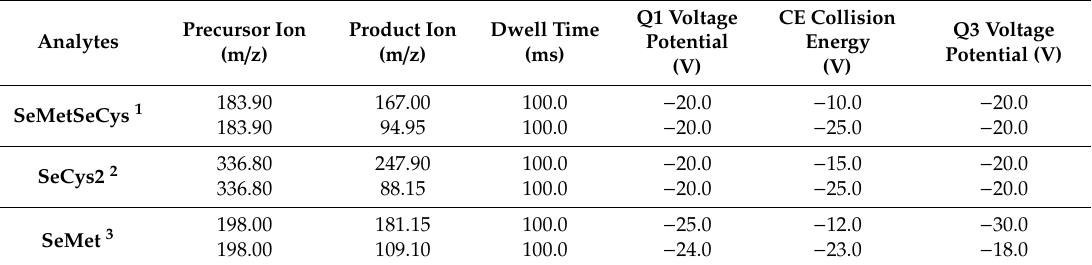
Table 2. The MS / MS parameters for the